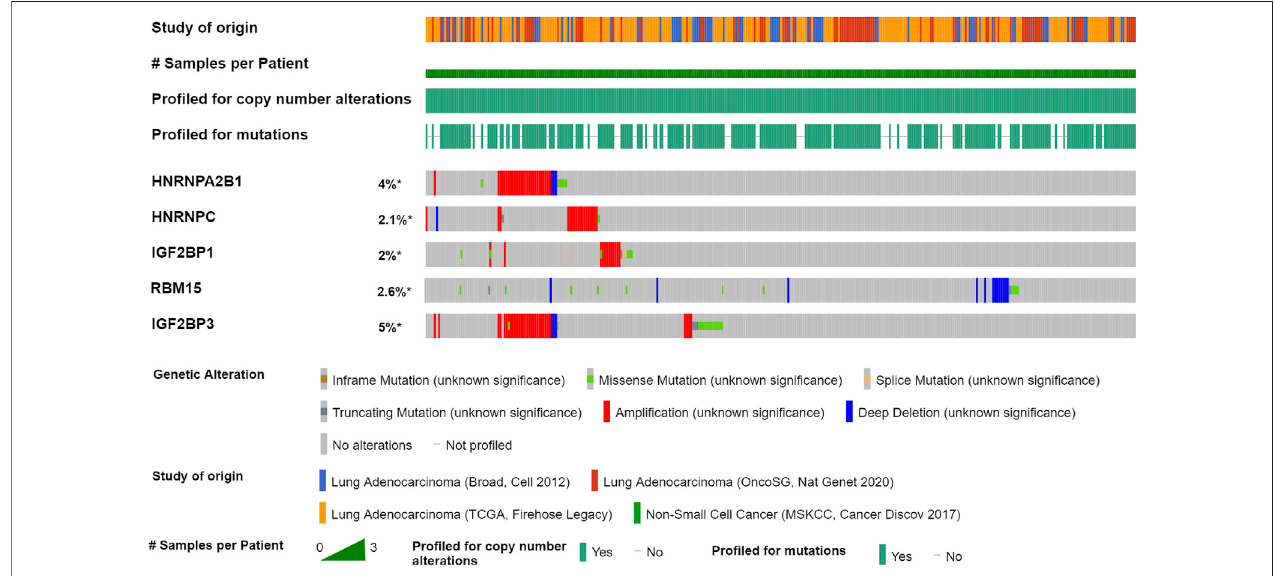
FIGURE 5 | Mutation of m 6 A modi fi cation regulators in LUAD by the cBioPortal database. Four studies were enrolled: LUAD (Broad, Cell 2012), LUAD (OncoSG, Nat Genet 2020), LUAD (TCGA, Firehose Legacy), and Non-Small Cell Cancer (MSKCC, Cancer Discov 2017). Atotal of1,989 LUAD sampleswere used toanalyze the genetic variation of m 6 A modi fi cation regulators in